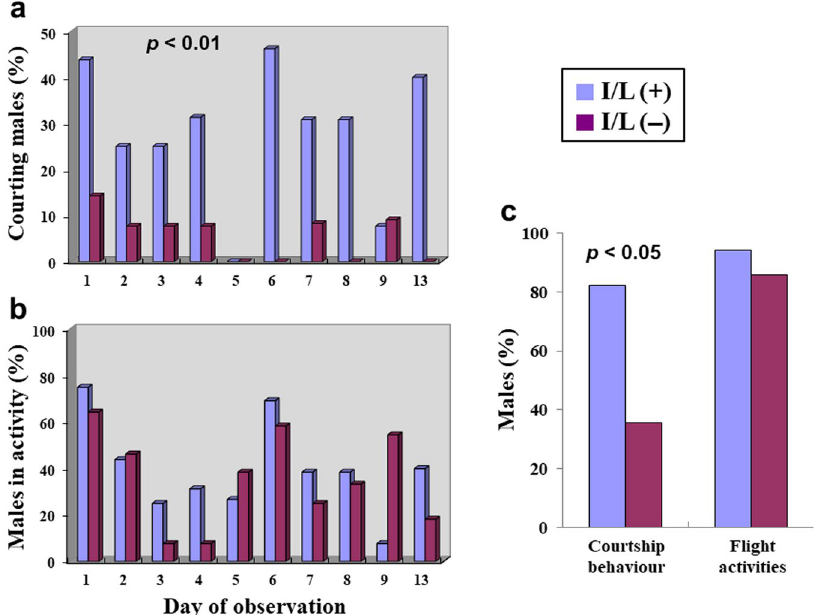
Figure 5. Behavioural patterns of I/L-fed and I/L-unfed males of Parantica sita . All of the males were devoid of the sex pheromone in the hairpencils owing to ablation of the sex brands prior to I/L administration. On days 10–12, observations were not made owing to rainy and stormy weather. ( a ) Percentage of males that displayed aerial pursuit of a female (courtship behaviour) at least once during each 1.5-hr observation period of the day. A significantly higher proportion of I/L-fed males [I/L( + )] courted females when compared with I/L-unfed males [I/L( − )] ( p < 0.01). ( b ) Percentage of the sum total of males that engaged in flight activities including pursuit, foraging or patrolling during each 1.5-hr observation period of the day. Resting males were not included. ( c ) Percentage of males that were observed to exhibit courtship behaviour or flight activities including pursuit, foraging or patrolling at least once during the whole experimental period. Eventually, the numbers of I/L-fed and I/L-unfed males available for data acquisition were 17 and 14, respectively. The proportion of males that courted females was significantly higher in I/L-fed males than in I/L-unfed ones ( p <